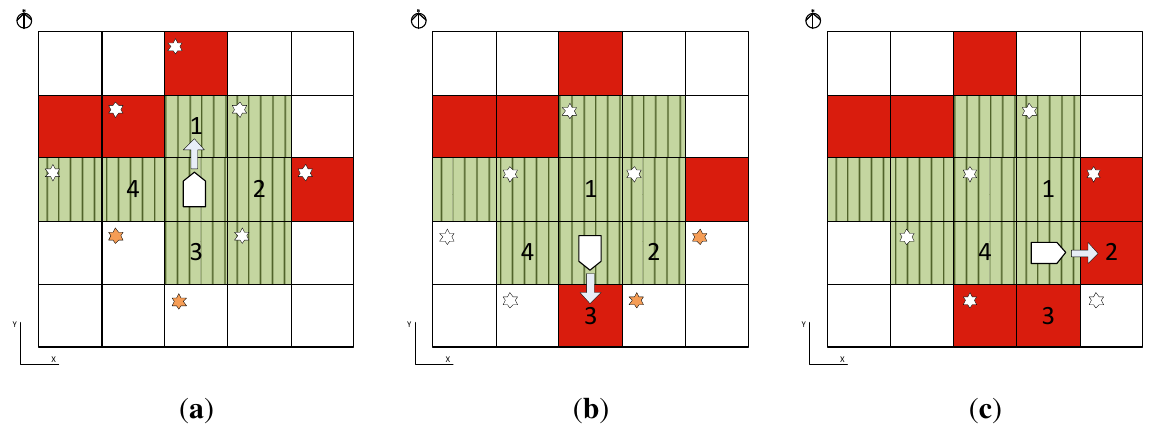
Figure 2. Next cell election. ( a ) Cell 3 is the first neighbor with uncharted adjacent cells. ( b ) Cell 2 is the first neighbor with uncharted adjacent cells. ( c ) Cell 4 is the only neighbor with uncharted and accessible adjacent